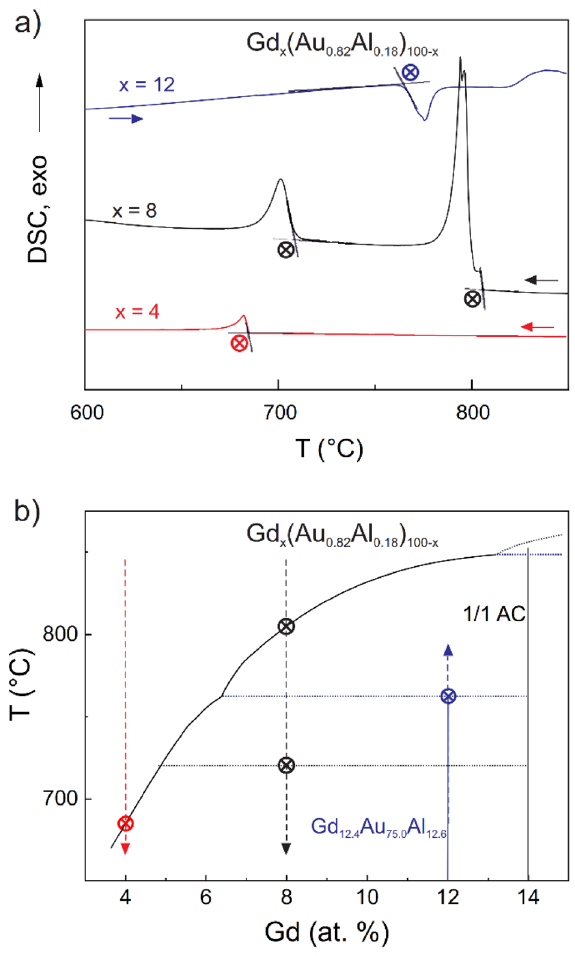
Figure 1. ( a ) DSC traces of samples Gd x (Au 0.82 Al 0.18 ) 100−x with x = 4, 8 and 12. Actual temperatures of endothermic (x = 12) and exothermic (x = 4, 8) events are obtained by extrapolation of heating and cooling curves, respectively. x = 12 corresponds to an isolated grain of the title compound GdAu 6.75−x Al 0.5+x (Gd 12.4 Au 75.0 Al 12.6 ). ( b ) Sketch of the envisioned partial pseudobinary Gd–(Au 0.82 Al 0.18 ) phase diagram. Note the discrepancy between peritectic formation and decomposition temperature (horizontal lines) for the title